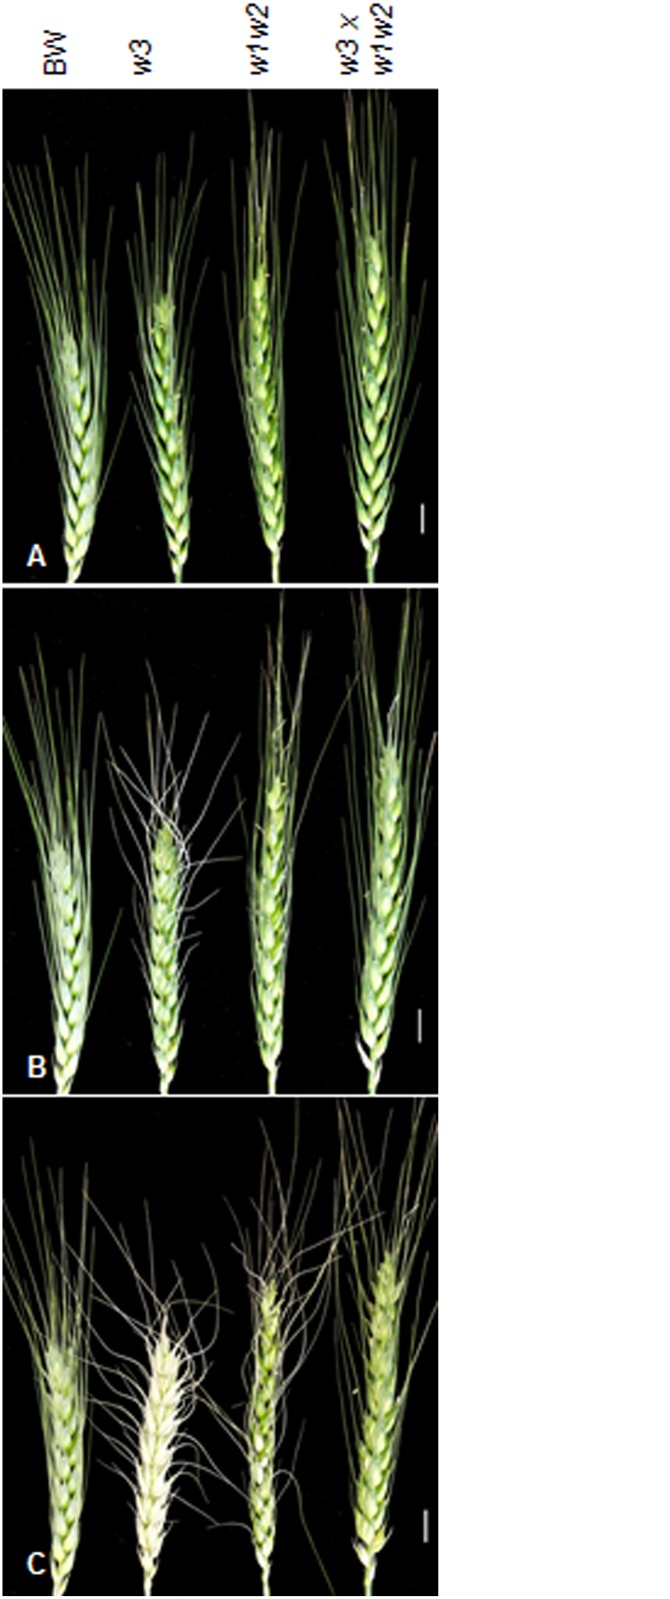
Spikes responses to dehydration.Spike of BW (W1W1W2W2W3W3), w3 mutant (W1W1W2W2w3w3), w1w2 double recessive line (w1w1w2w2W3W3), and the F1 hybrid between w3 and w1w2 (W1w1W2w2W3w3) at 0 (A), 6 (B) and 12 h of dehydration (C). The designations are indicated on the top. The scale bars indicate 1 cm.